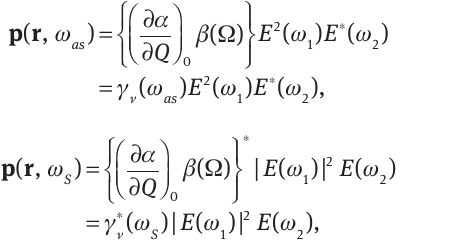
and ω are incident on a molecule, 1 2 − ω and producing 1 2